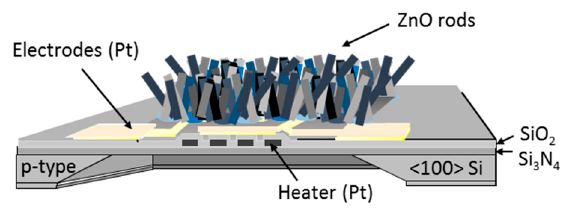
Figure 1. Schematic view of the micromachined sensor based on columnar ZnO